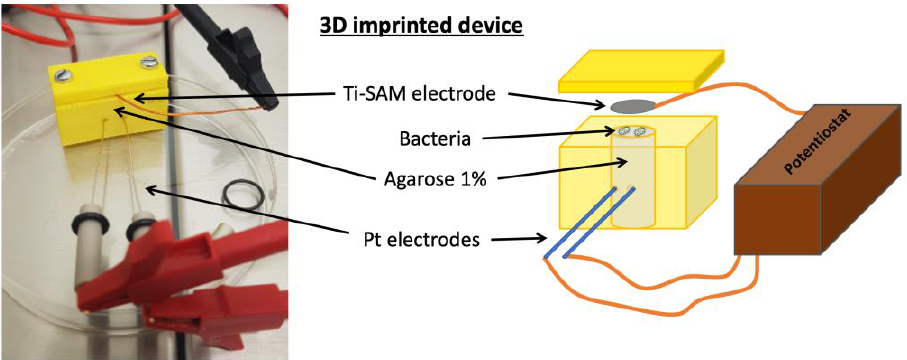
Figure 6. Photograph and schematic representation of the imprinted device. On the scheme the empty chamber was filled with a 1% agarose gel on which was deposited a solution of bacteria c.a. 10 8 CFU/mL and covered on the top by the Ti disk.